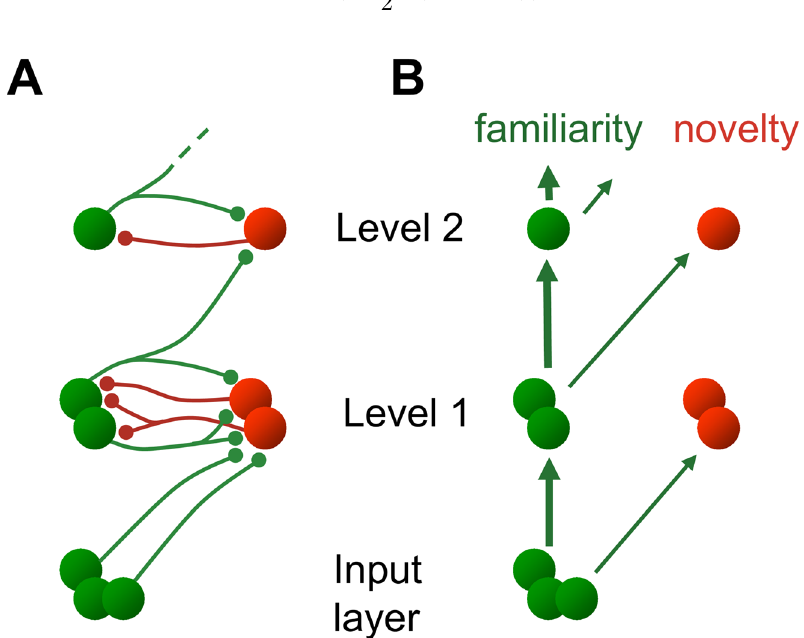
Fig 2. Anatomical versus effective connectivity. A Schematic anatomical connectivity pattern in the early ventral visual cortex shows recurrent synaptic connections within each level (Eq (4)). Lower-level ‘ familiarity ’ neurons (green) project to ‘ novelty ’ neurons (red) at the next higher level. B Effective connectivity expressing causal relationships results in a purely feedforward network (Eq (5)). At each level, familiarity and novelty information is extracted from the familiarity representation at the previous